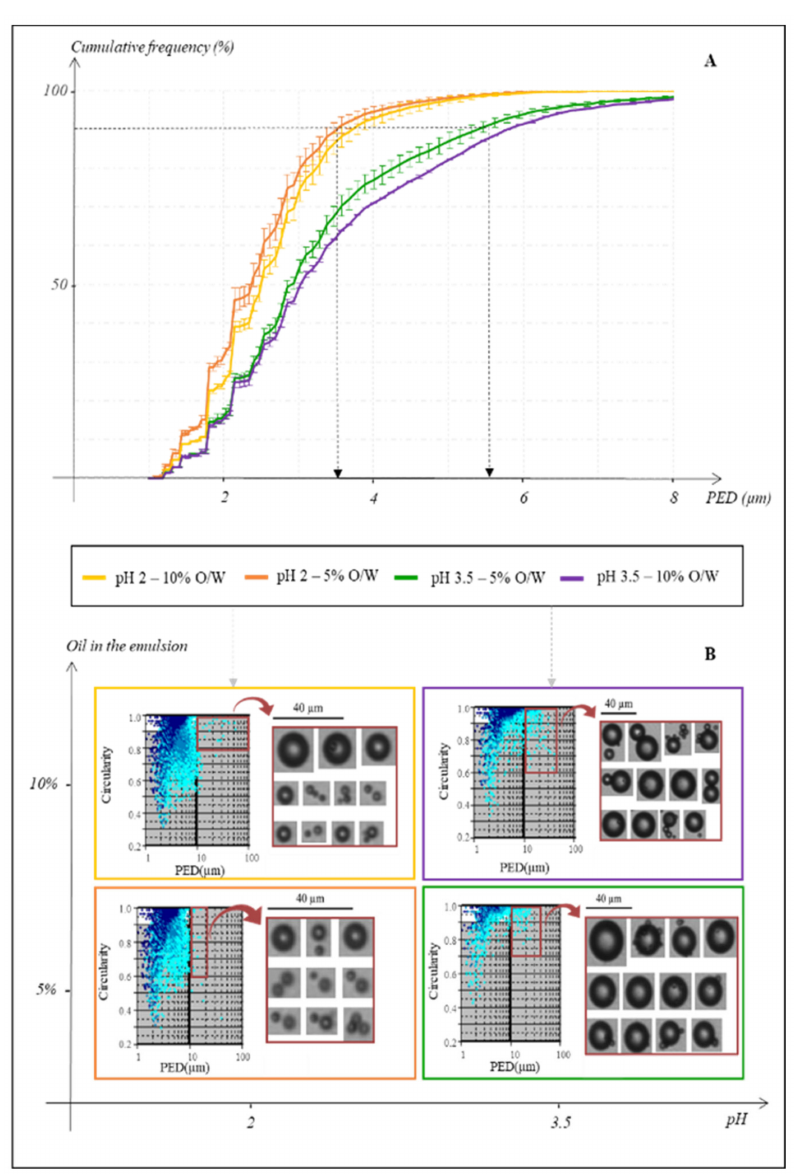
Figure 3. Characterization of emulsions according to the modulation of two parameters: pH (2 or 3.5) and the amount of oil in water (5% or 10%). ( A ): Cumulative frequencies of the droplets enumerated (%) as a function of the PED ( µ m). The differences of perimeters at 90% of the enumerated particles are highlighted. ( B ): Characterization profiles of the emulsions, representing the circularity of the particles as a function of the PED ( µ m). The blue colour scale indicates the density of the identified particles: from cyan blue for single droplets to dark blue for several of them. The white background corresponds to the most accurate particles eager to be lipid droplets (PED < 10 µ m and circularity from 90% to 100%). Representative pictures shot by the FPIA of the largest particles of each emulsion are